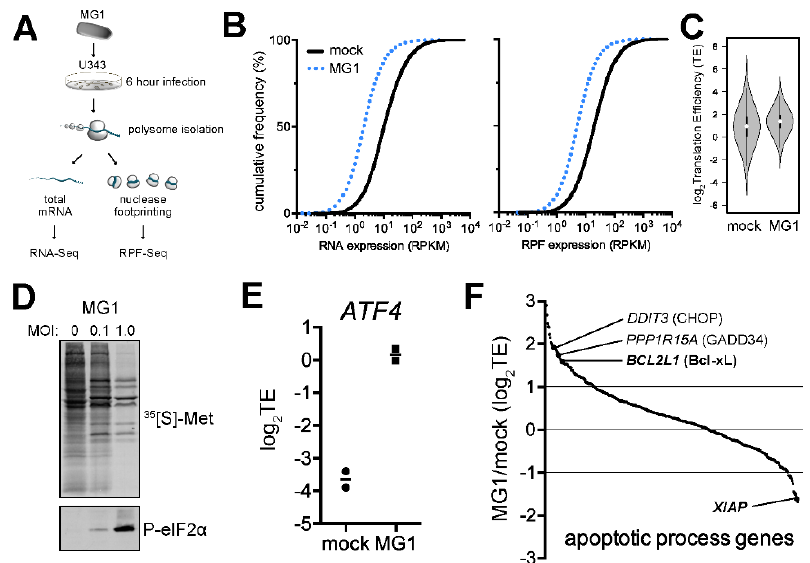
Figure 1. Ribosome profiling of MG1-infected U343 cells highlights cellular targets of eIF2 α phosphorylation and apoptosis. ( A ) Schematic of the ribosome profiling strategy used. Polysomes were fixed using cycloheximide prior to extraction. RPF; Ribosome protected fragments. ( B ) Cumulative frequency distributions of gene expression at the transcriptome (RNA) and translatome (RPF) levels in mock and MG1-infected cells. ( C ) Violin plots showing distribution of the translation efficiency (TE = RPF/RNA) for sequenced genes between mock and MG1-infected U343 cells. The median (central dot), interquartile range (black box), 95% confidence interval (vertical line) are shown, while the grey area represents a density plot wherein the width is proportional to the frequency of the TE values. ( D ) Radiograph (top) showing nascent peptide synthesis in mock-infected U343 cells (0 MOI) or increasing MOI of MG1 virus. Western blot (bottom) probing for phospho-eIF2 α . ( E ) TE of ATF4 , a known translational target of phospho-eIF2 α , in mock- vs. MG1-infected U343 cells. ( F ) Distribution of TE for genes classified as “apoptotic processes” by the Gene Ontology consortium. Two known translation substrates of phospho-eIF2 α , CHOP and GADD34 demonstrated enhanced TE, while other apoptotic regulators such as Bcl-xL and XIAP exhibited antipodal TEs. **** p < 0.0001; determined using a non-parametric Kolmogorov-Smirnov statistical test.